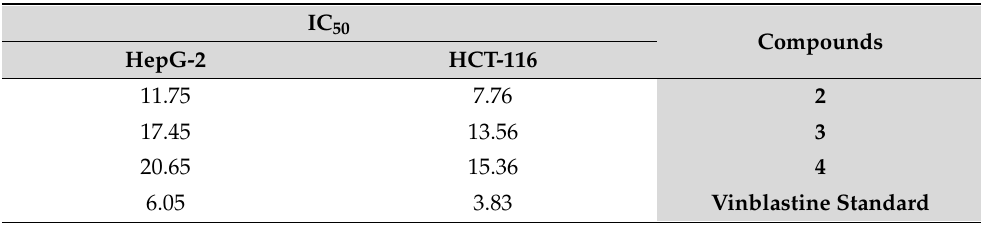
Table 12. IC 50 of the synthesized compound ( 2 – 4 ) on colon carcinoma cells (HCT-116) and hepatocel- lular carcinoma cells lines